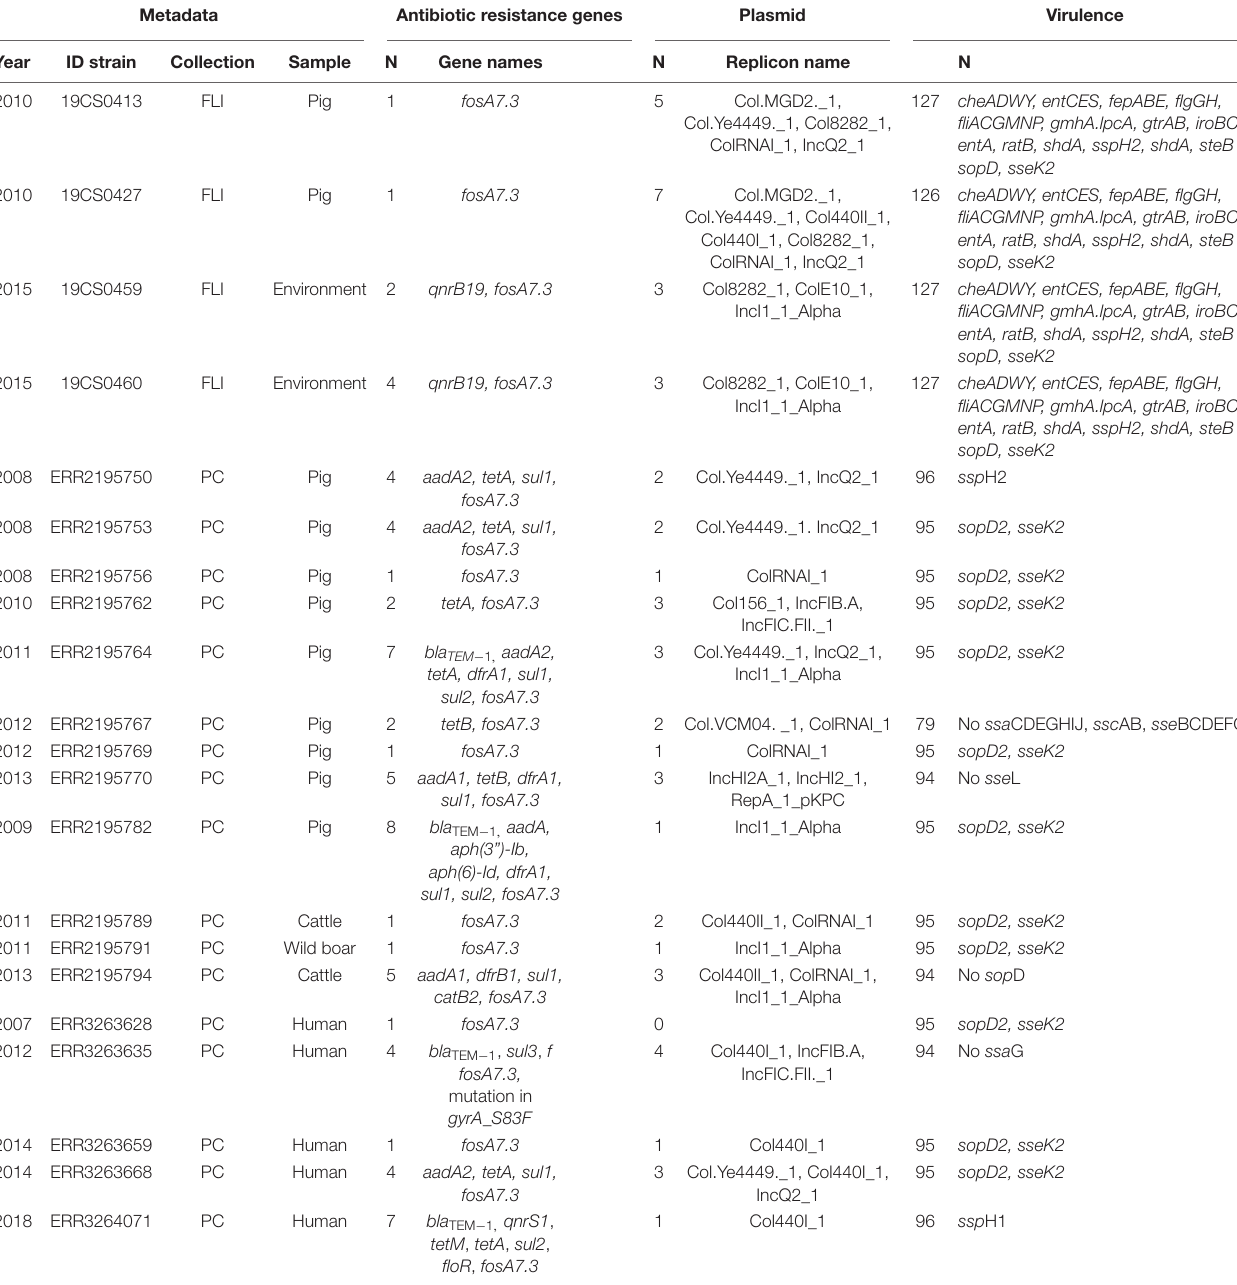
TABLE 3 | ST40 genome information about the antimicrobial resistance genes, plasmid replicons and virulence genes, n = 21. Metadata Antibiotic resistance genes